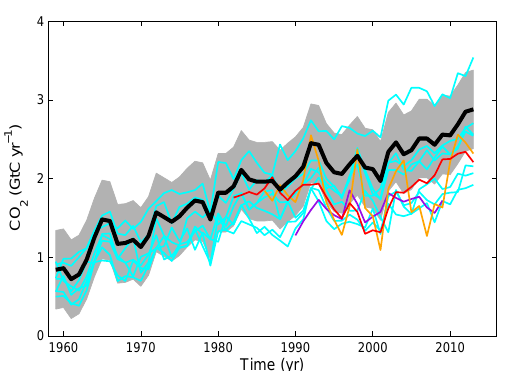
Figure 7. Comparison of the atmosphere–ocean CO 2 flux shows the budget values of S OCEAN (black line), individual ocean mod- els before normalisation (blue lines), and the three ocean data- based products (Rödenbeck et al. (2014) in orange, Landschützer et al. (2014) in red, and Park et al. (2010) in purple; see Table 6). All data-based products were corrected for the pre-industrial ocean source of CO 2 from river input to the ocean, which is not present in the models, by adding a sink of 0.45GtCyr − 1 (Jacobson et al., 2007) in order to make them comparable to S OCEAN . This correc- tion does not take into account the anthropogenic contribution to river fluxes (see Sect.